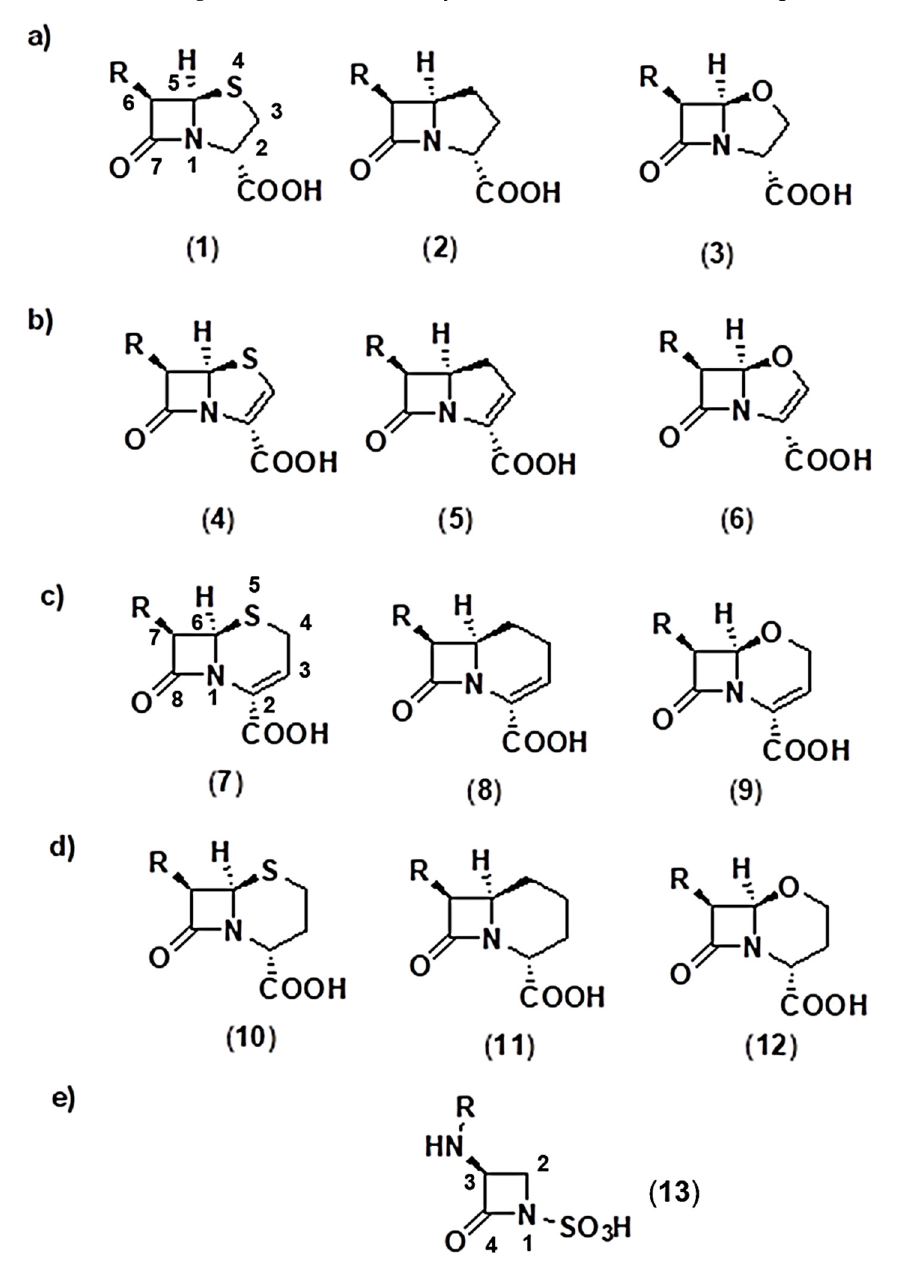
Figure 1. The β -lactam core structures. Penams ( 1 ), carbapenams ( 2 ), oxapenams ( 3 ) ( a ); penems ( 4 ), carbapenems ( 5 ), oxapenems ( 6 ) ( b ); cephems ( 7 ), carbacephems ( 8 ), oxacephem ( 9 ) ( c ); cepham ( 10 ), carbacepham ( 11 ), oxacephem ( 12 ) ( d ); monobactam ( 13 ) ( e ).